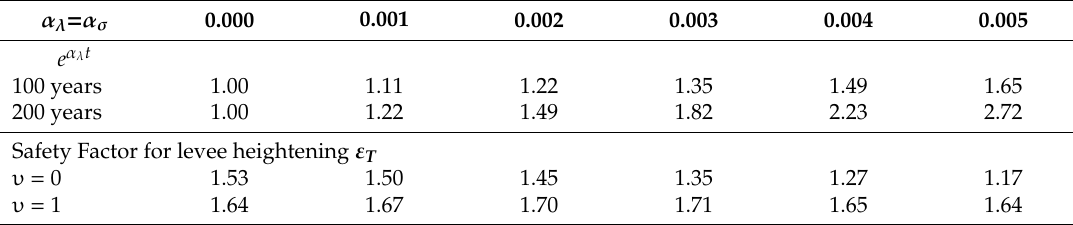
Table 8. Impact of climate change for the high value case. Upper section: multipliers for frequency and intensity changes for the 100 and 200-year time horizon respectively. Lower section: optimal levee heightening strategy (for two cases: υ = 0: only extension required after event, υ = 1: rebuilding and extension required after event).